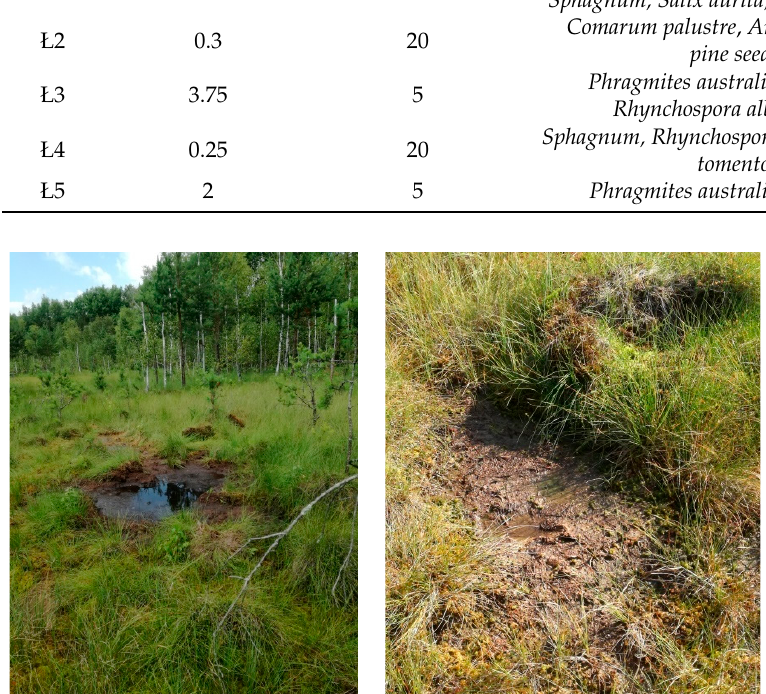
Figure 3. Places of animal activity in the mid-forest peat bog in the Sobibór Forests. Table 4. Significance of differences in the cover of the layer of trees (A), shrubs (B), herbaceous (C), The resettlement area ranged from 0.06 m 2 (Lake Orchowe 1-O1) to 0.4 m 2 in peat and mosses (D) at individual bogs. The degree of the overgrowth of potential sites varied greatly, from 25% (Lake P ł otycze 1-P ł 1) to even 80% (Lake P ł otycze 2-P ł 2, Ocrchowe 2-O2 and Podlaski-Pd). There were mainly Sphagnum , Carex , Vaccinium oxycoccos , and Eriophorum vaginatum . Tree seed- lings also appeared (Table 4).